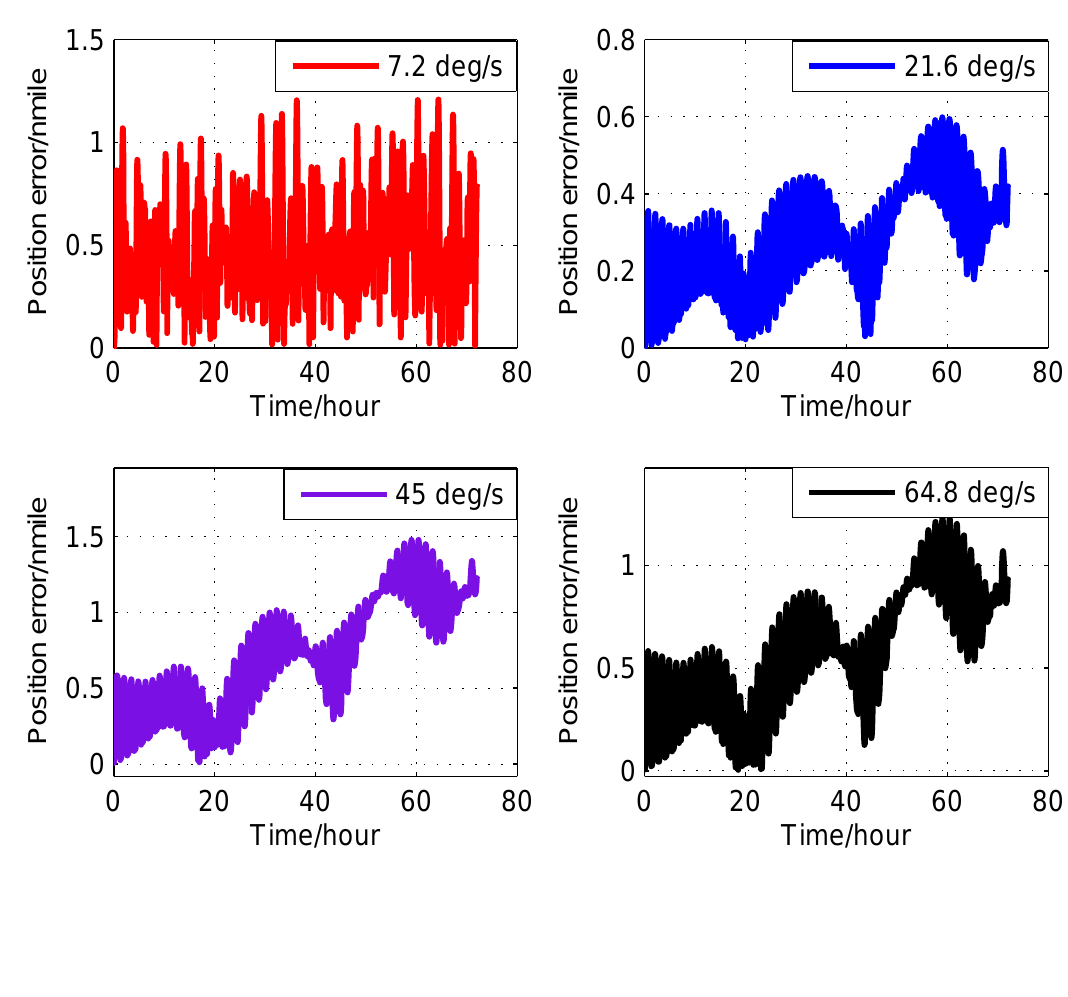
Figure 9. Simulation results of Group